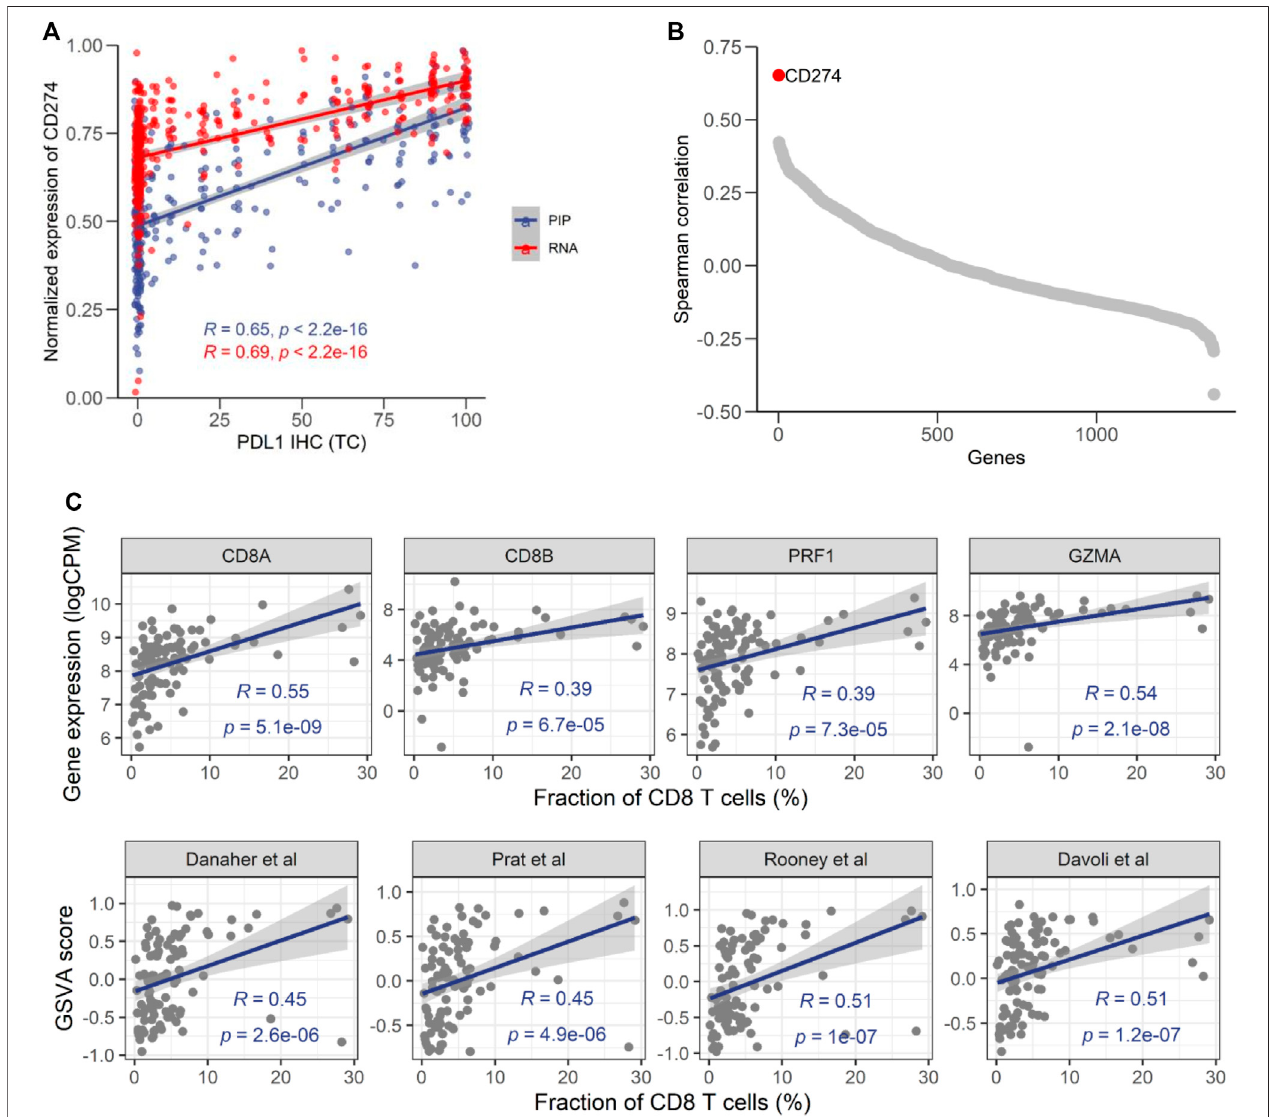
FIGURE 5 | Consistency of EdgeSeq PIP with PD-L1 IHC and CD8 IHC. (A) Correlation of the CD274 mRNA expression level from EdgeSeq PIP (blue) and RNA- seq (red) with the PD-L1 TC score. (B) Spearman correlation coef fi cients ( y -axis) of mRNA expression level assessed by EdgeSeq PIP with the PD-L1 level assessed by IHC. Each dot represents a gene and genes were ordered according to their Spearman correlation coef fi cients ( x -axis). (C) Scatterplot showing the correlation of CD8 related genes (top) and signatures (bottom) with CD8 + T cell fraction estimated by IHC (%).